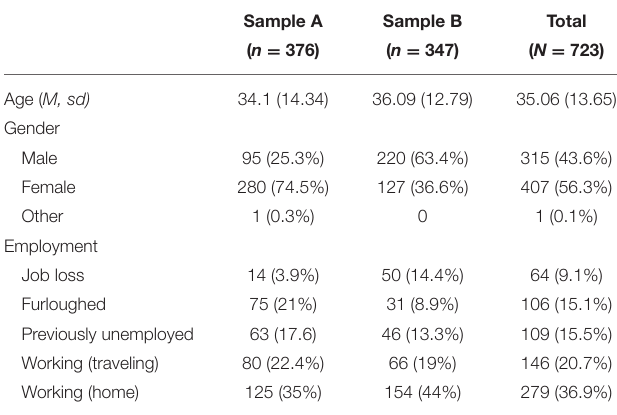
TABLE 1 | Demographic variables for